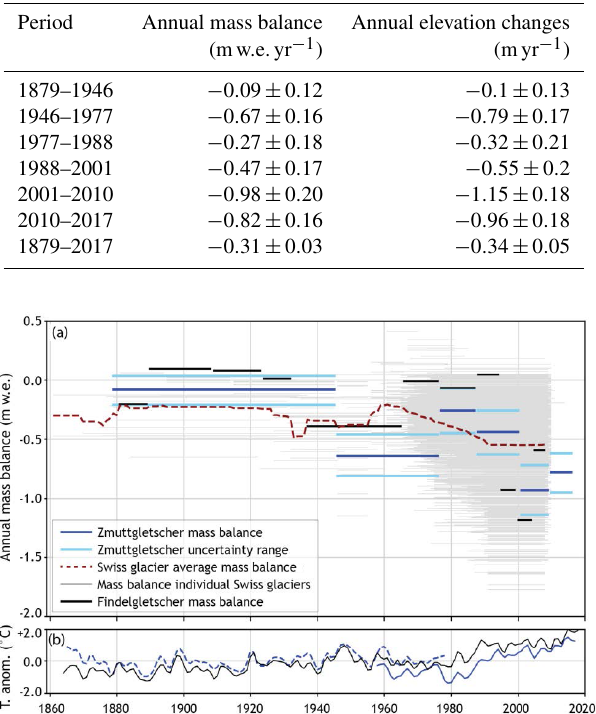
Table 2. Glacier-wide surface elevation changes and geodetic mass balance of Zmuttgletscher.